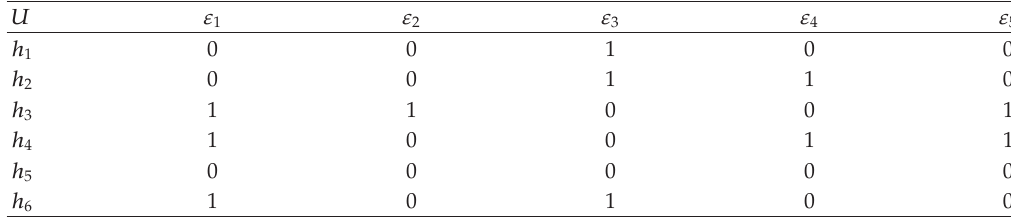
Table 5: Tabular representation of the level soft set L (cid:5) S ; α , λ (cid:6)